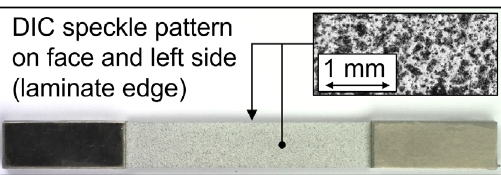
Figure 2. Prepared specimen with end tabs and digital image correlation (DIC) pattern for deformation